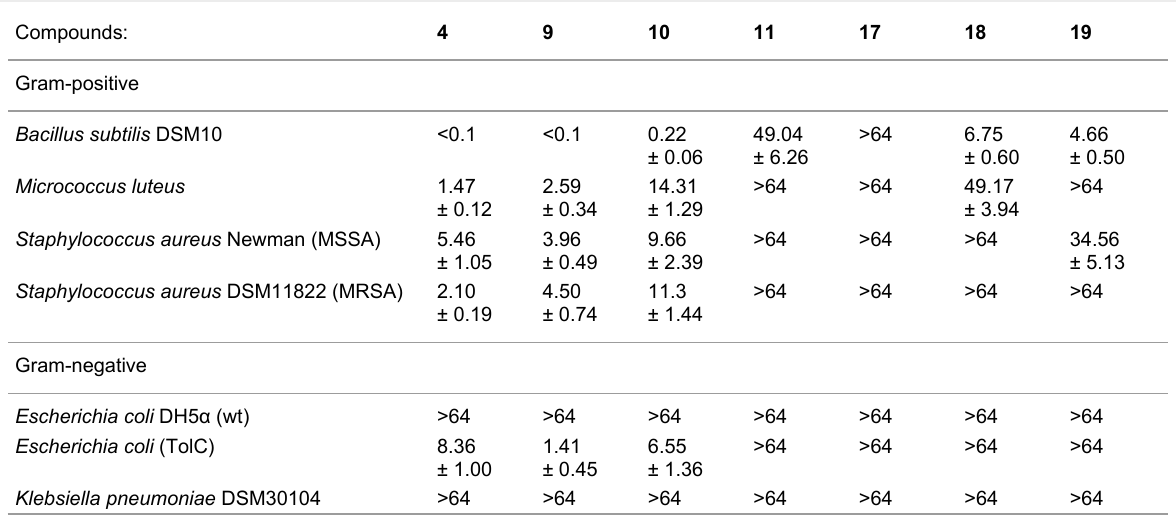
Table 4: Antibacterial activities of 4(1 H )-quinolone derivatives (MIC 50 , µg/mL). a